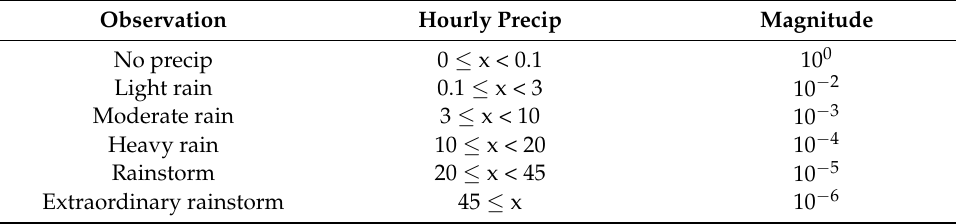
Table 2. Magnitude distribution of hourly precipitation (Unit: mm).